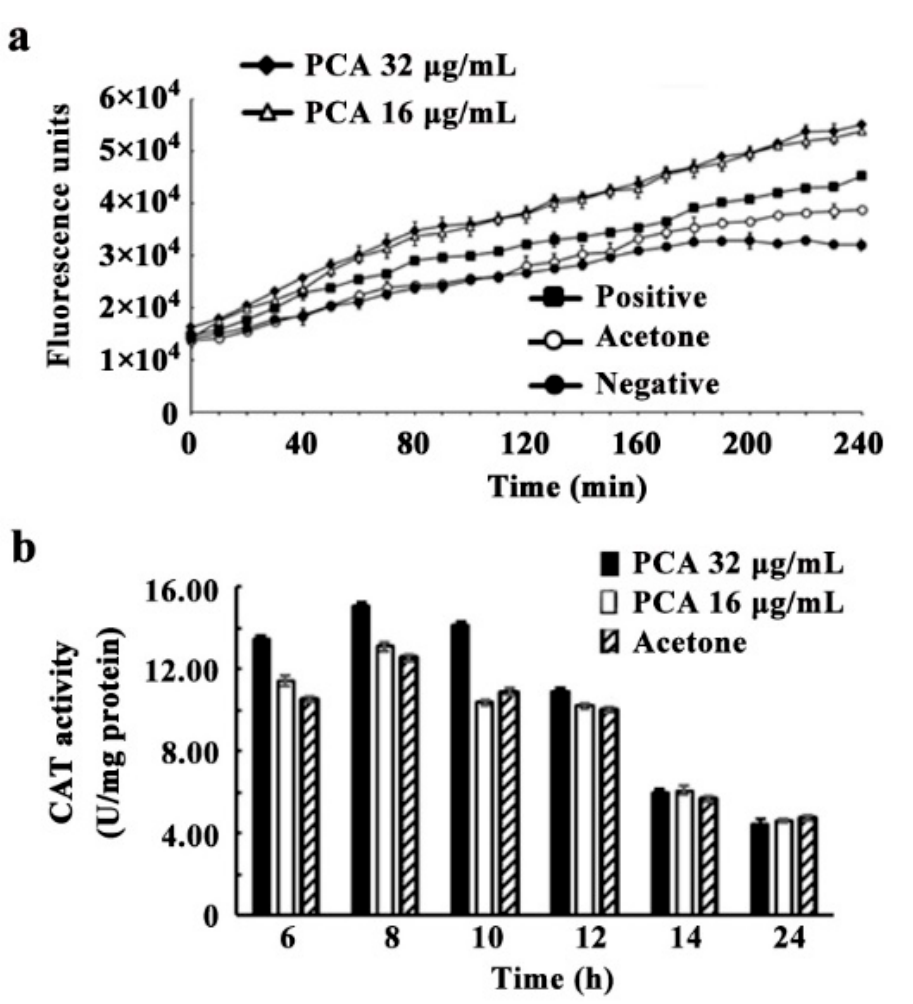
Figure 7. ROS accumulation ( a ) and CAT ( b ) activity of A. citrulli strain XJX12 induced by PCA. The treatments included PCA in acetone and acetone alone. ROS accumulation was measured based on fluorescence in microplates, the wells of which contained a bacterial suspension and no additional agent (the negative control) or one of the following: PCA at 0, 16, or 32 μ g/mL, with 0.4% ( v / v ) acetone (as the solvent) in each case; acetone alone (0.4%, v / v ); or Rosup reagent (a positive control provided with the assay kit). The experiment was repeated three times.